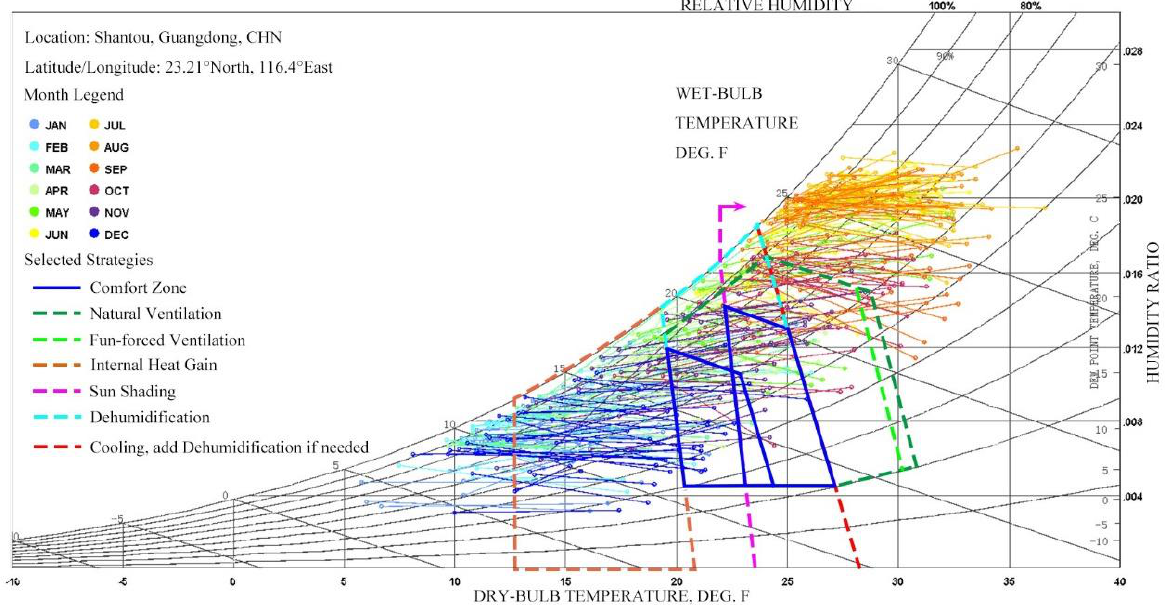
Figure. 2 The bioclimatic chart of Shantou